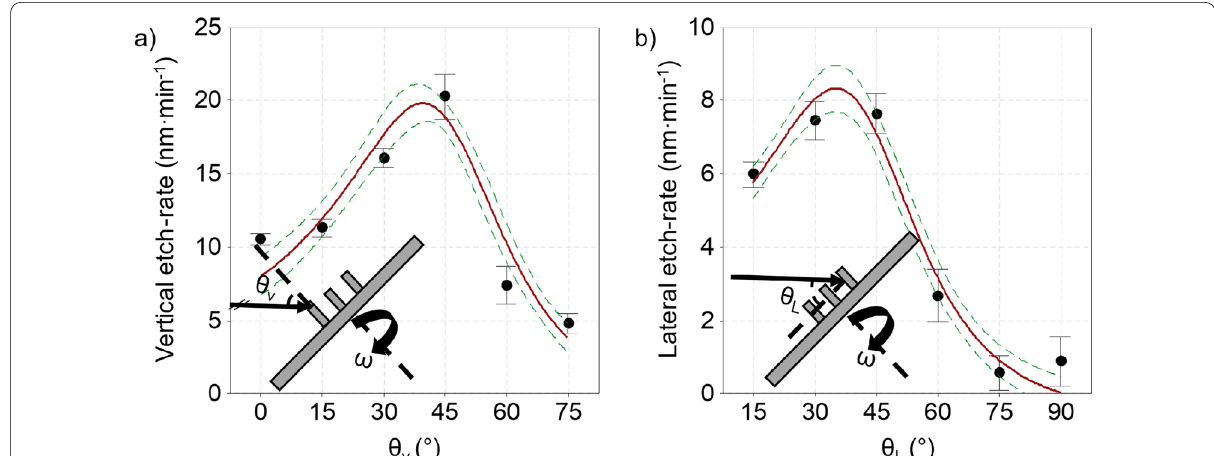
Fig. 3 Results for the vertical and lateral etch rate as a function of the vertical ( θ V ) and lateral ( θ L ) incident angle. The interval plots represent the measured data considering a 95% CI with N 6. The fitted red solid lines represent the mean etch rate. The green dotted line shows a 95% CI of the = regression